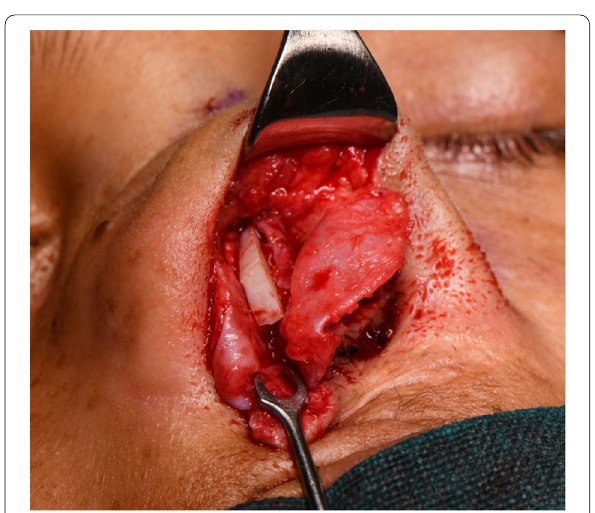
Fig. 2 Paramedian, transverse, and lateral osteotomies only on the cleft side, the cleft side is mobilized and elevated with an elevator